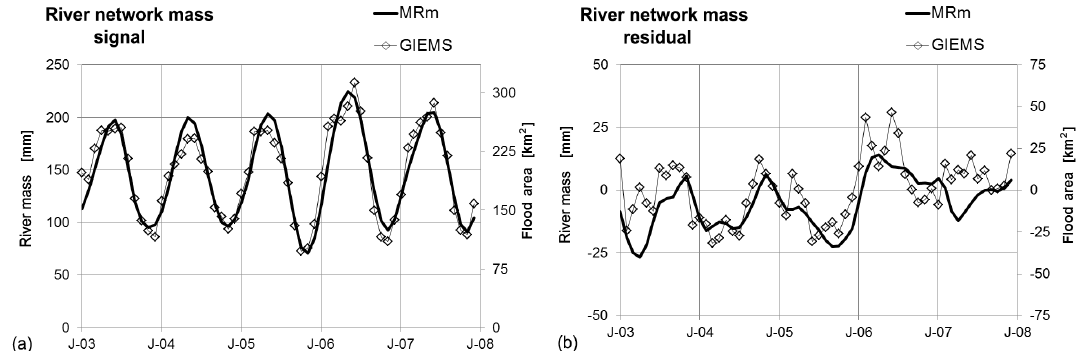
Figure 10. Time series of river network storage M R m and inundated area from GIEMS for the Amazon and optimization versus GRACE for the signal (a) for the residual (b) . Table 1. The statistical characteristics are listed for calculated river runoff R R , total mass M T , basin mass M C , river network mass M R , observed river runoff R o , GRACE mass anomalies and flood areas from GIEMS using the following: root mean square error (RMSE) of simulated versus measured values, Nash–Sutcliffe coefficient of the signal (NS S ) (simulated values versus long-term mean of measured values), Nash–Sutcliffe coefficient of monthly residuals (NS R ) (simulated values versus monthly mean of measured), correlation of simulated versus measured signals (corr S ), correlation of simulated versus measured monthly residuals (corr R ). Avg and SD are the long-term mean and standard deviations. The prefix “d” is used for anomalies related to the long-term mean. Results are compared for the different optimization references: runoff ( R o ) or GRACE for recharge from water balance ( R + d M/ d t ) (A, B) and for atmospheric input ( − div Q ) (D, E). The cascaded storage approach is compared to the single storage approach in (C, F).